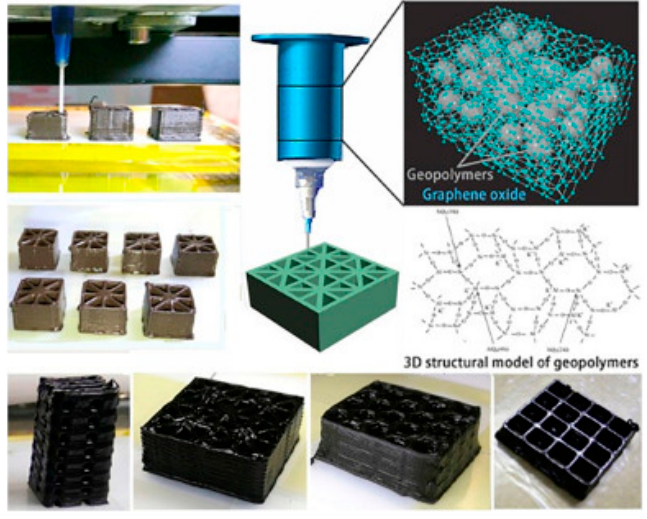
Figure 10. Schematic illustration of the 3D-printing process and some 3D-printed structures. Reprinted with permission from Reference [135]. Copyright © 2017 Elsevier.